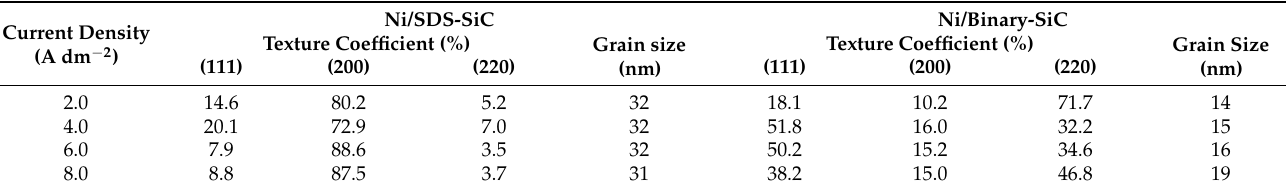
Figure 3. Structure characterization. XRD patterns of composite coatings, ( a ) Ni/SDS - SiC, ( b ) Ni/bi- nary - SiC. XPS spectra of composite coatings at the current density of 2.0 A dm −2 , ( c ) survey spectra, ( b ) Ni/binary-SiC. XPS spectra of composite coatings at the current density of 2.0 A dm − 2 , ( c ) survey Table 1. Texture coefficient and grain size of composite coatings. Table 1. Texture coefficient and grain size of composite